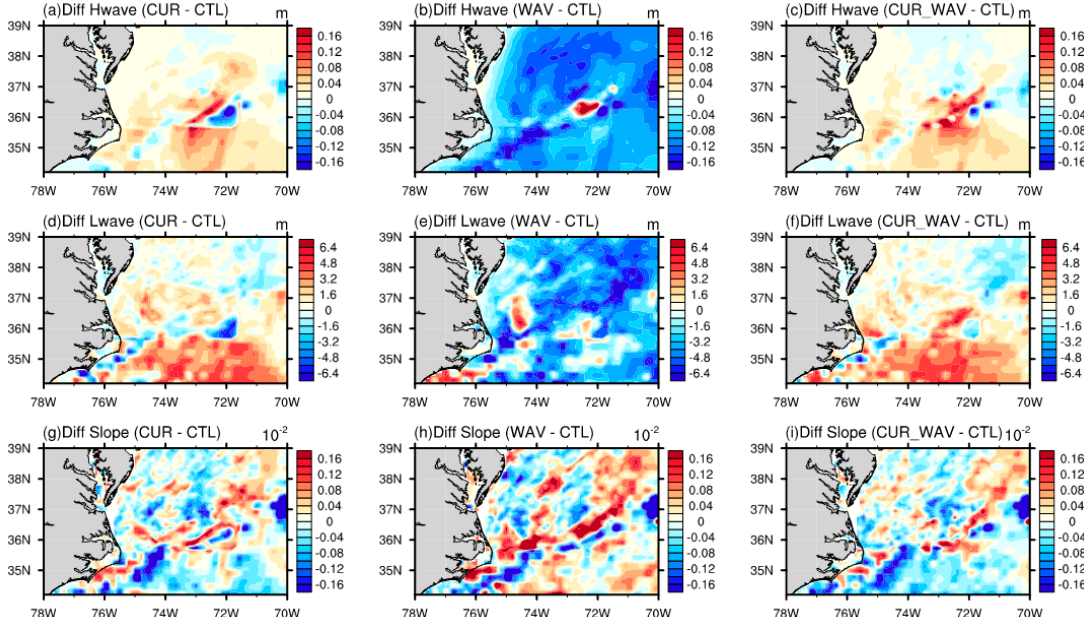
Figure 6. Comparing the 30 day averaged changes of ( a – c ) significant wave height (in meters), ( d – f ) wave length (in meters), and ( g – i ) wave slope (hundredths) among current–stress coupling (left panel), wave–stress coupling (middle panel), and three-way coupling (right panel).